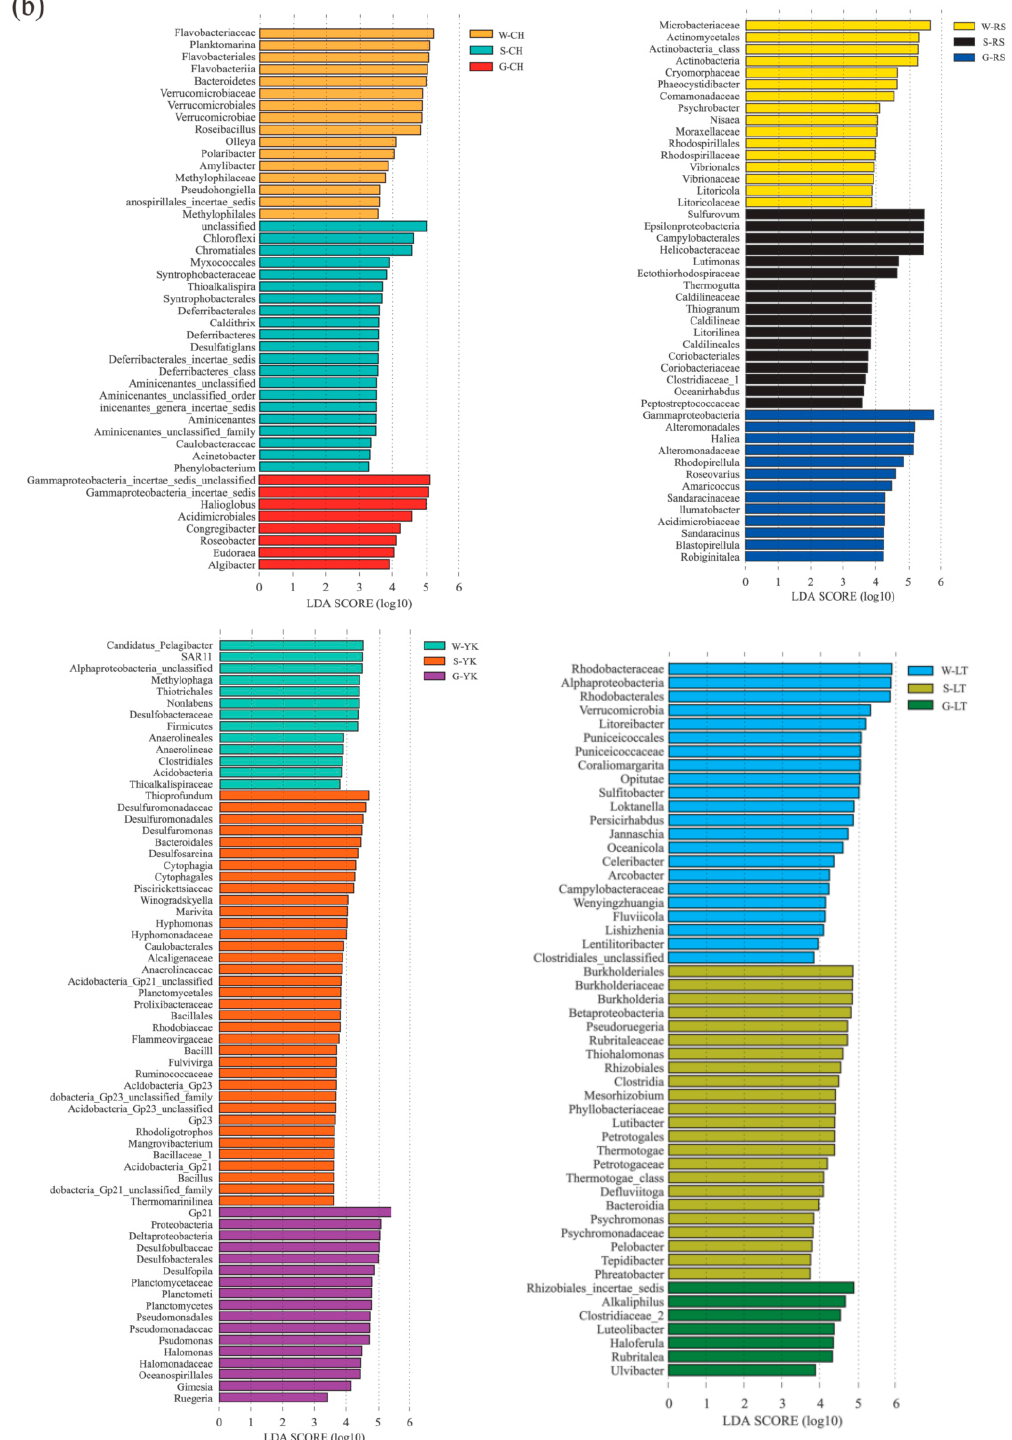
Figure 6. LEfSE method identified the significantly specific abundant taxonomy among multiple media (water (W), sediment (S), and the gut of in Apostichopus japonicus (G)) in different areas (Changhai (CH), Rushan (RS), Yingkou (YK), and Laoting (LT), China). Biomarkers for each group are represented in different colors. The circles represent the phylogenetic level from domain to genus from inside to outside. Only taxonomies that met an LDA significance threshold of >3 are defined in this figure. ( a ) Taxonomic cladogram based on LEfSe analysis. ( b ) Histogram of LDA